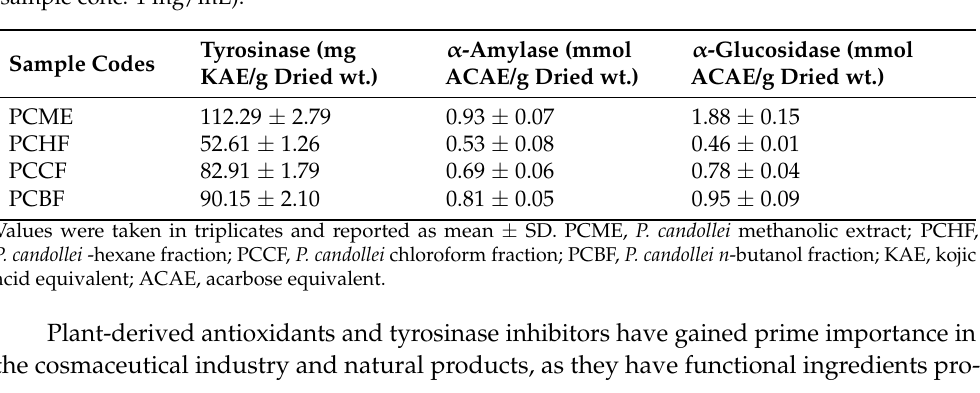
Table 5. Enzyme-inhibitory activities of methanolic extract and different fractions of P. candollei (sample conc. 1